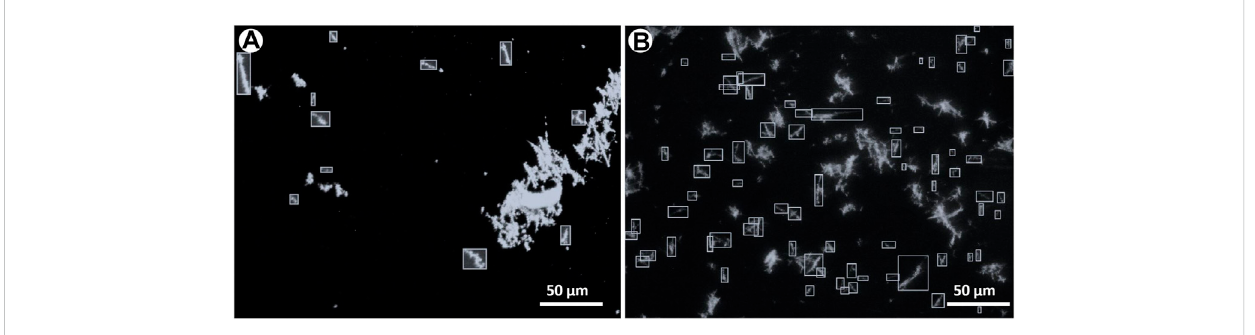
FIGURE 8 The same optical microscopy images as in Figure 5 where asbestiform fi bres have been manually annotated as bounding boxes for counting. The choice of the fi bres to annotate has been based on NIOSH (Ashley and O ’ Connor, 2017) counting rules, see text for explanation. (A) Drop and (B) micro- drop depositions.